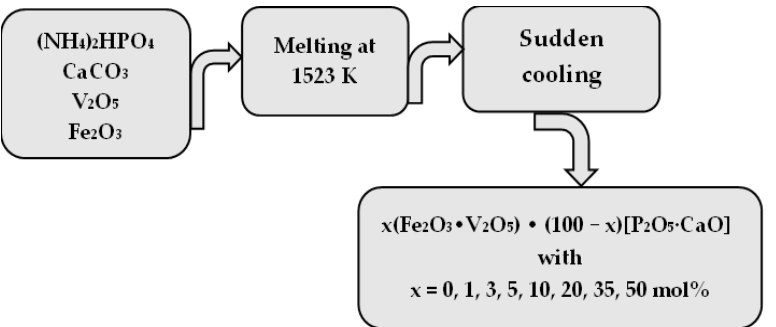
Figure 5. Scheme of the preparation procedure of the compounds x(Fe 2 O 3 · V 2 O 5 ) · (100 − x) [P 2 O 5 · CaO] with x = 0, 1, 3, 5, 10, 20, 35, 50 mol%.